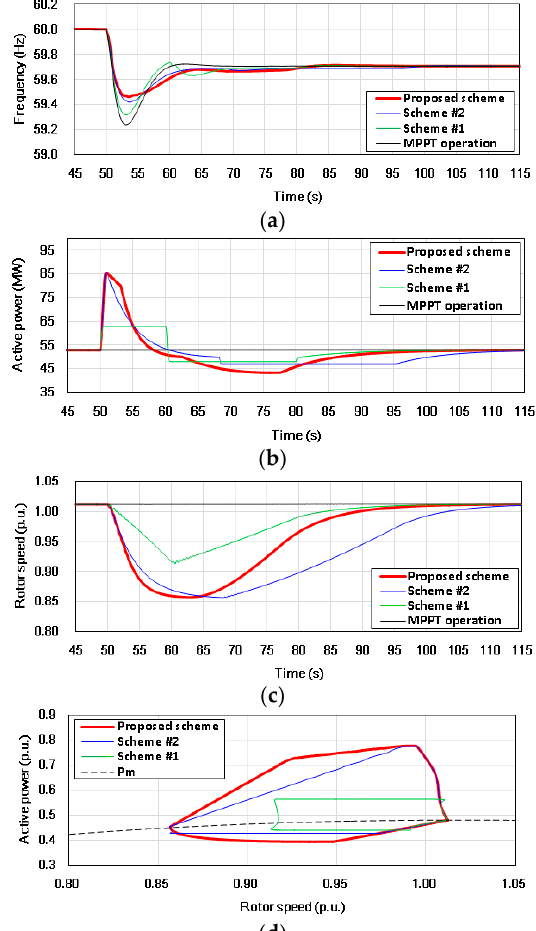
Figure 7. Results for Case 2. ( a ) system frequencies; ( b ) WPP outputs; ( c ) Rotor speeds; ( d ) Figure Power–speed trajectories.